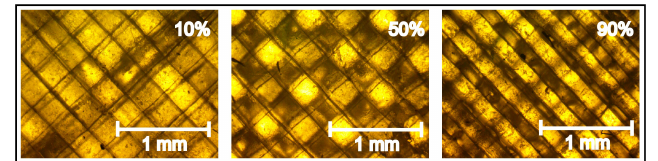
Figure 6. Relative permittivity box figures of rectangular infill pattern.